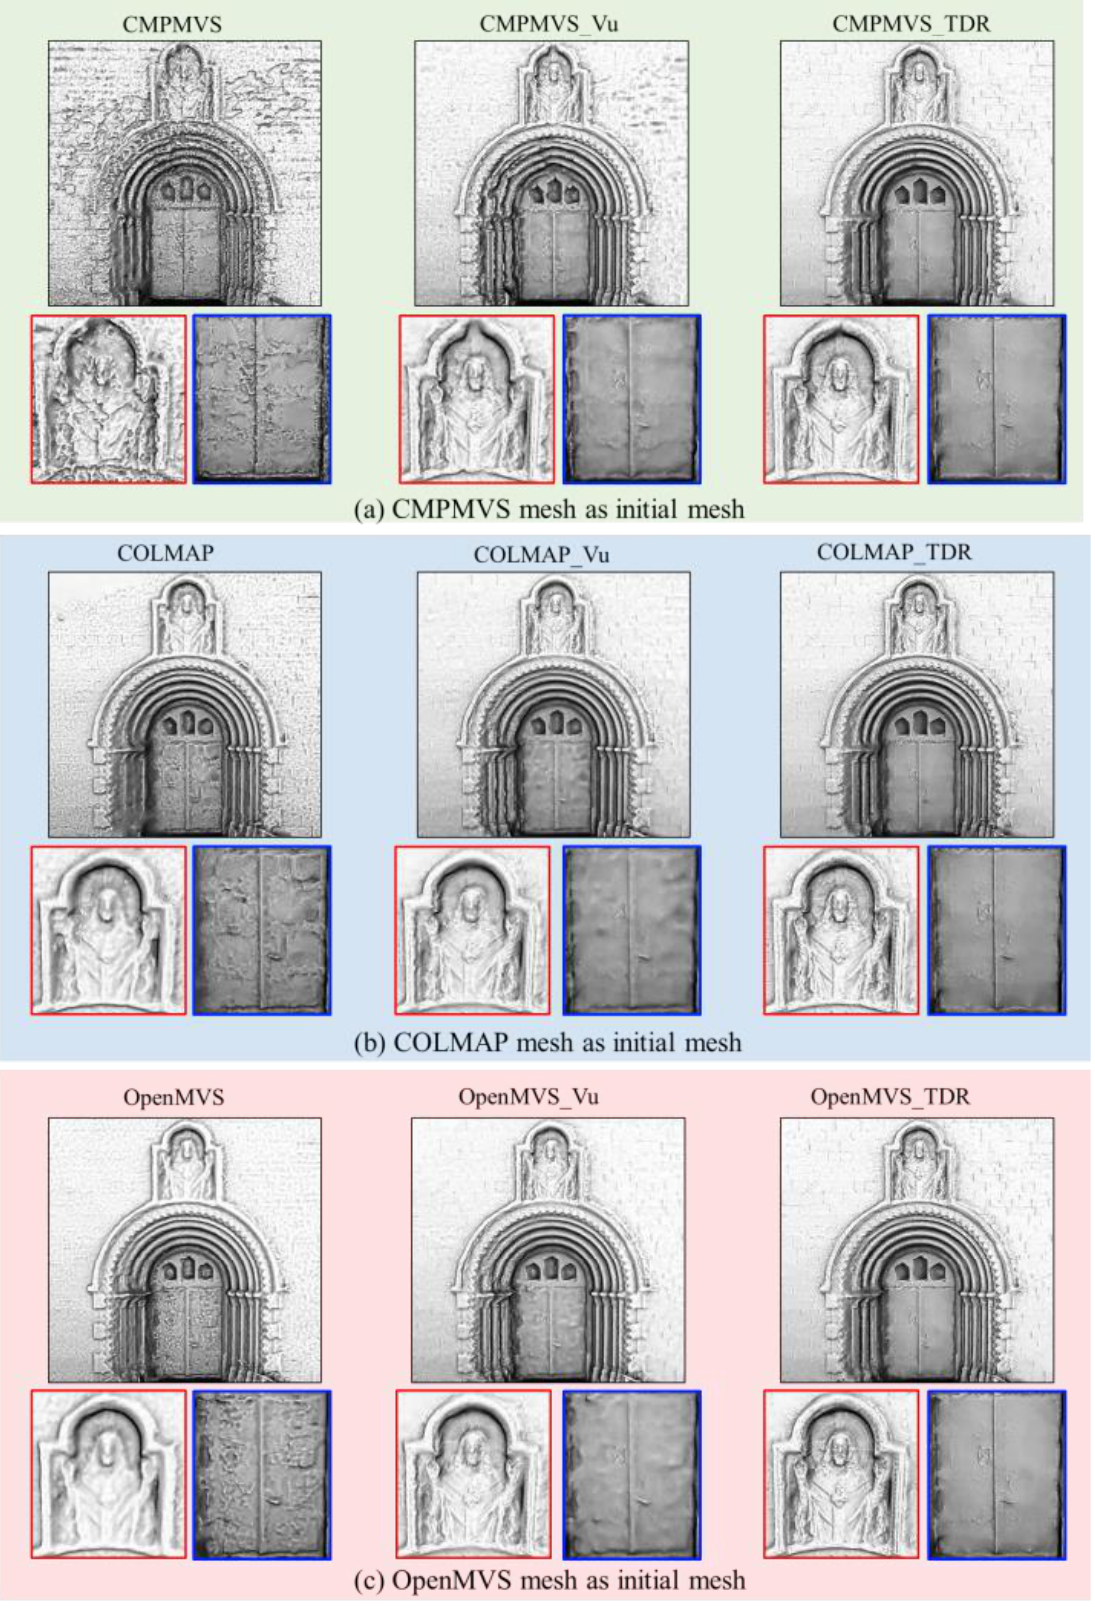
Figure 13. Visualization of the results of all methods on Herz-Jesu-P8.